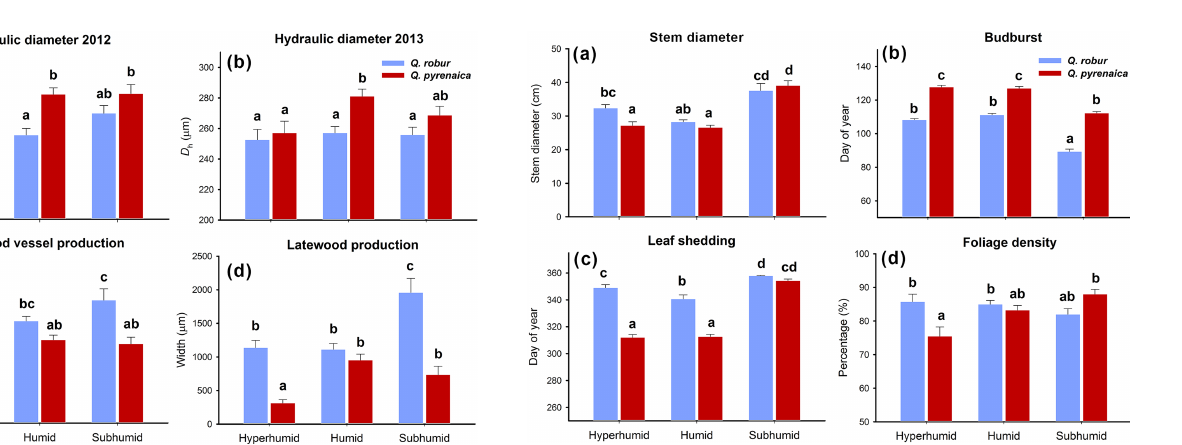
Figure 4. Mean values and SE of (a) hydraulic diameter in 2012, (b) hydraulic diameter in 2013, (c) earlywood vessel production, and (d) latewood production in 2013 for Quercus robur ( N = 120) and Q. pyrenaica ( N = 120). Lower-case letters indicate statisti- cally significant differences along the gradient according to multiple pairwise comparisons.